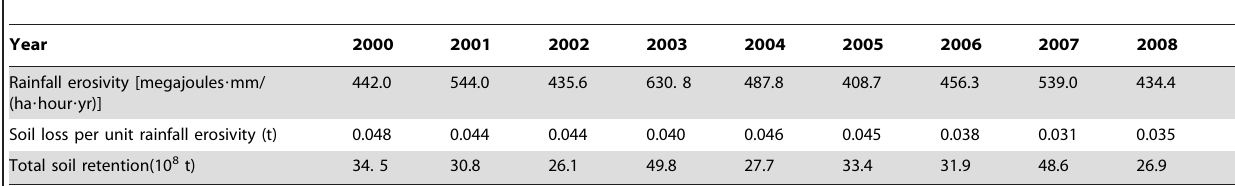
Table 1. Rainfall erosivity and soil retention characteristics in the Loess Plateau region from 2000 to 2008.